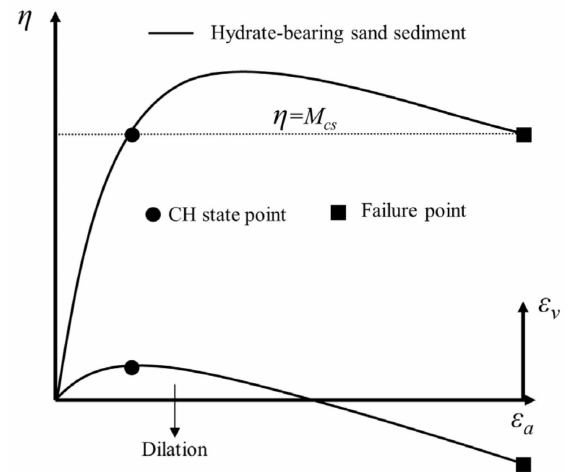
Figure 11. Typical mechanical characteristics curves for hydrate-bearing sand sediments in triaxial compression tests under drained conditions